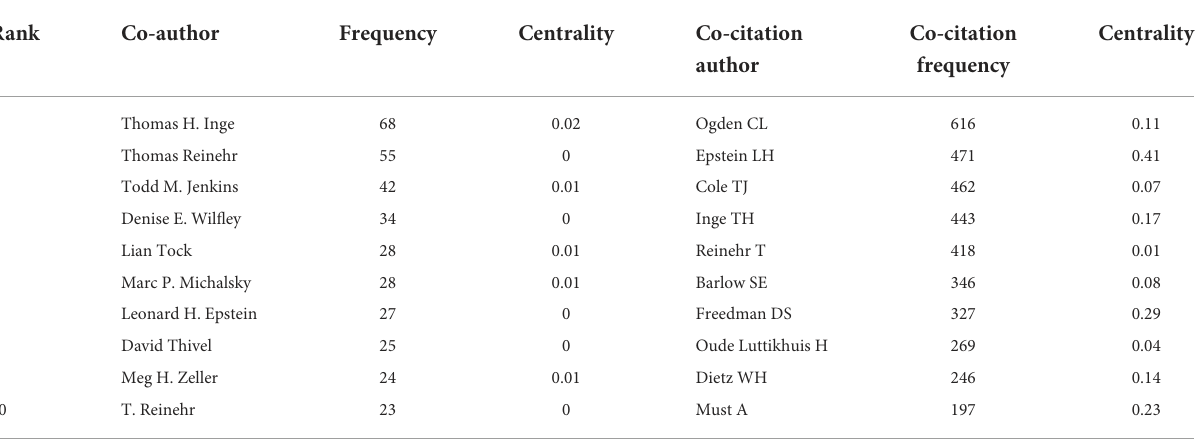
TABLE 2 Top 10 co-author and co-citation author by